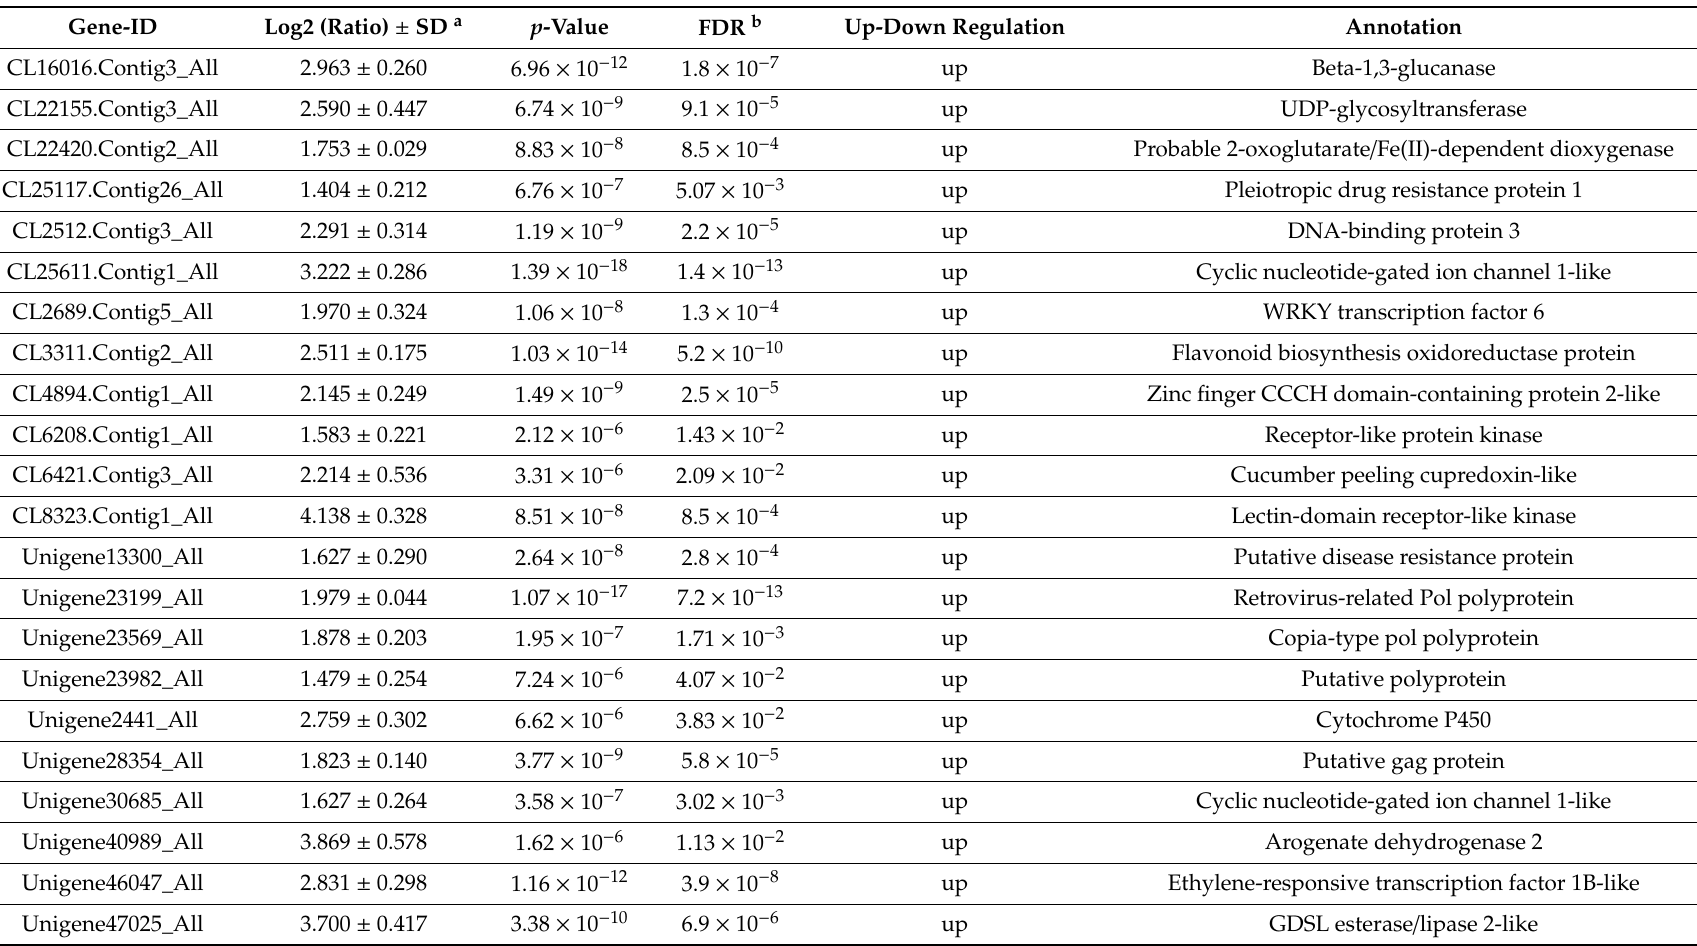
Table 2. List of di ff erentially expressed genes (DEGs) in response to TYLCCNA in N. benthamiana